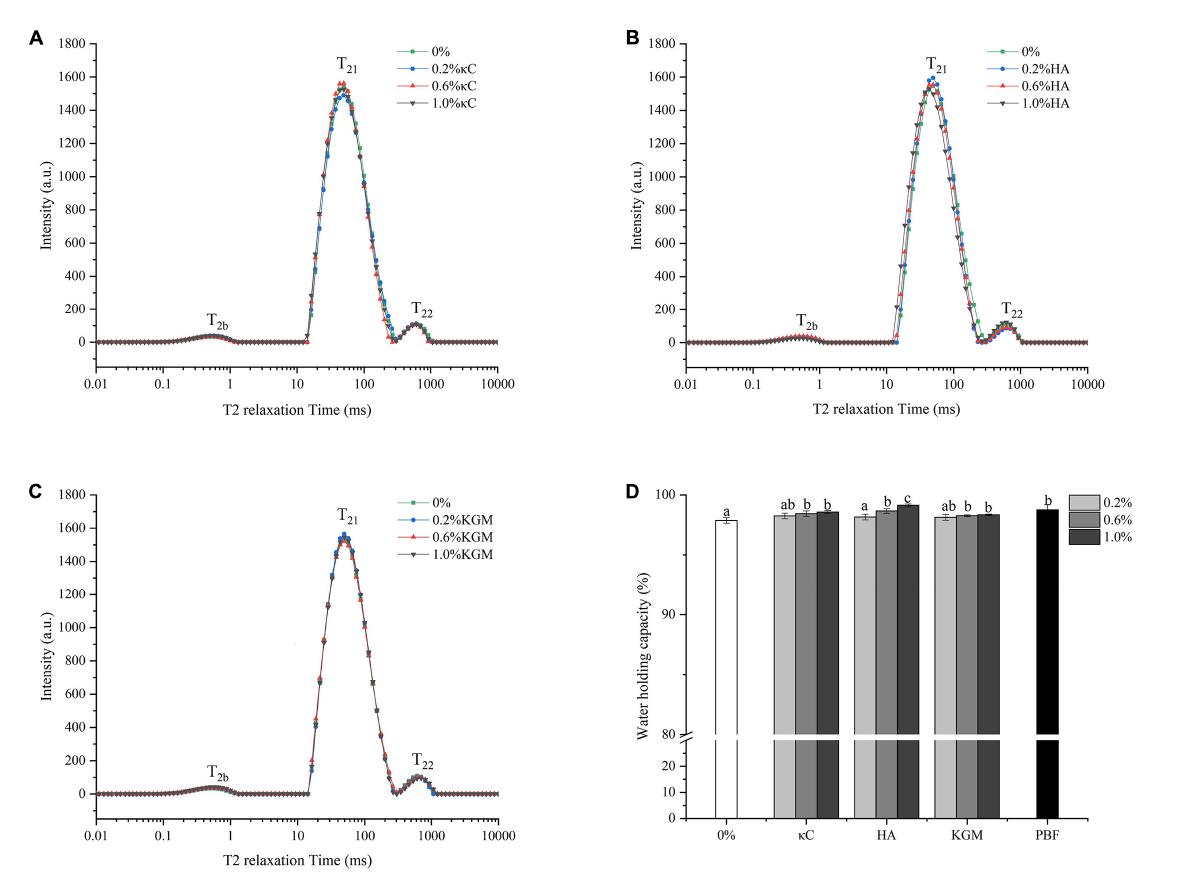
FIGURE8 Water holding properties of emulsion gels containing different polysaccharides. (A–C) Transverse relaxation curves; (D) Water-holding capacity. Different letters indicate that the values are significantly different ( P < 0.05). κ C, κ -carrageenan; HA, high-acyl gellan; KGM, konjac glucomannanon; PBF, pig back